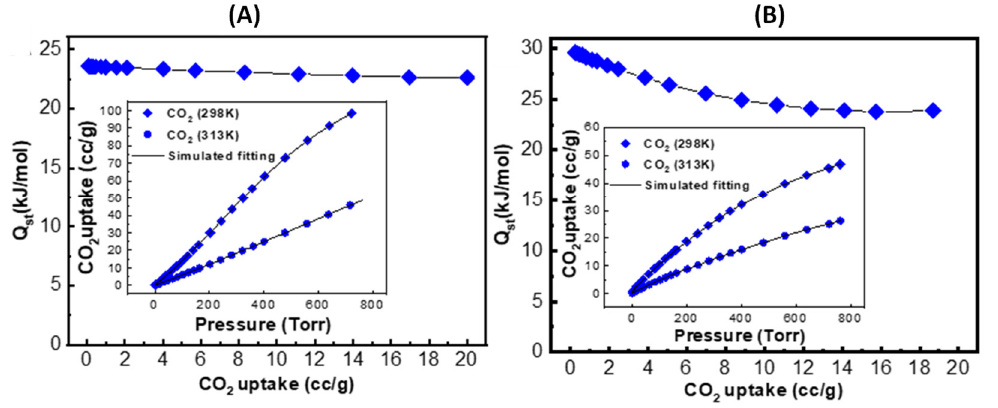
Figure 12. Qst value of ( A ) ZIF-90 and ( B ) 50-PSM-ZIF-90.